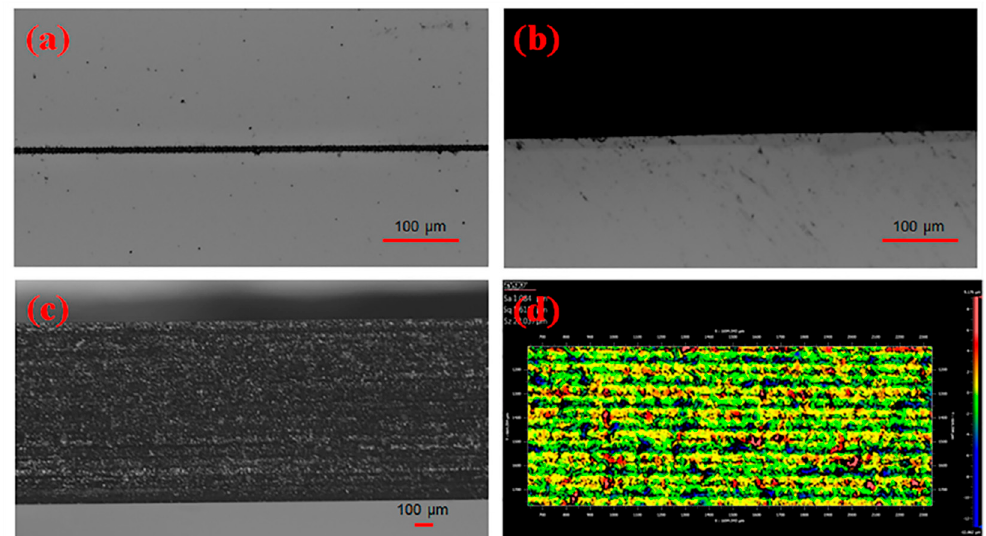
Figure 8. Images of the top surface of the LiNbO 3 modulator ( a ) before and ( b ) after the breaking process. Images of side surface detected by digital microscopy ( c ) and white surface interferometer ( d ) were also attached.